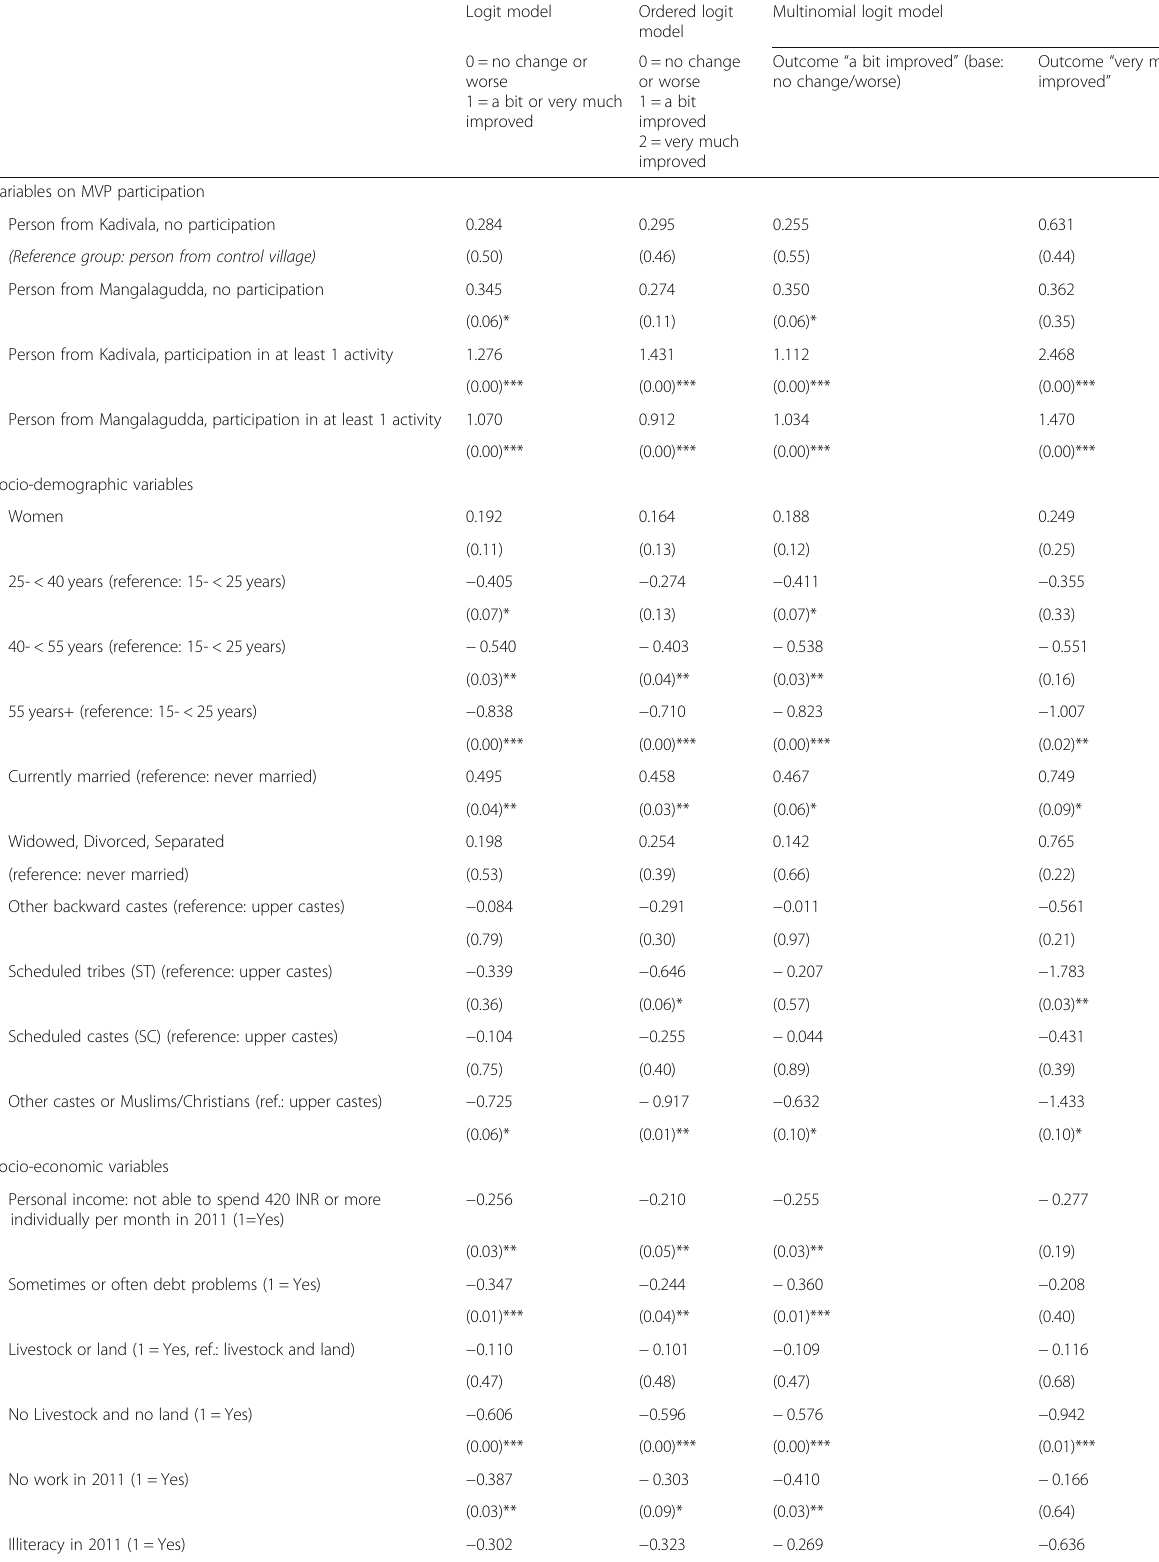
Table 2 Results from multivariate analyses. Estimated